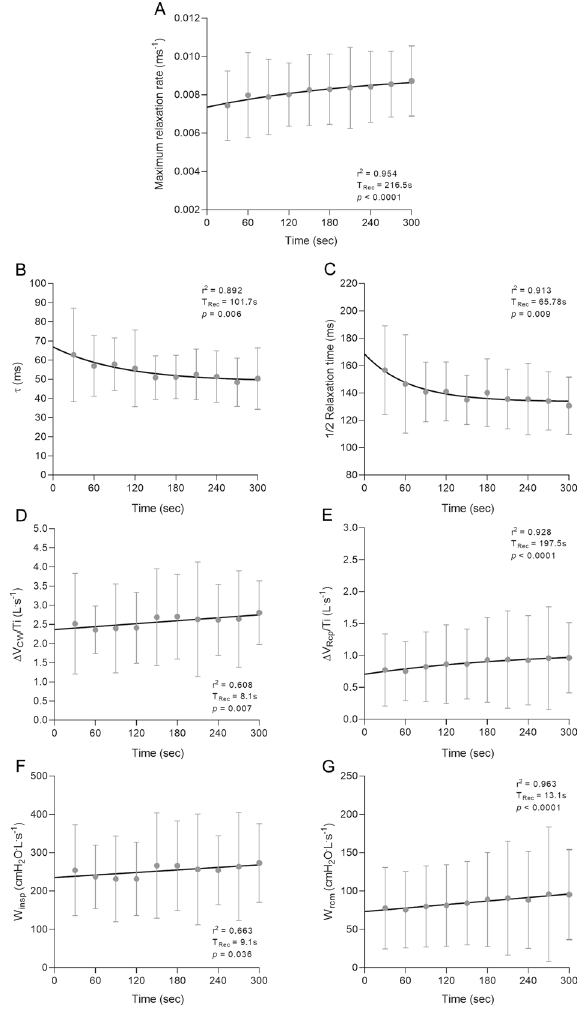
Figure 6. Time course of the recovery pattern of maximum relaxation rate (panel A ), time constant of the relaxation curve (τ—panel B ), half-time of relaxation curve (½RT—panel C ), mechanical power of global inspiratory ( Ẇ insp —panel D ) and inspiratory ribcage muscles ( Ẇ rcm —panel E ), and shortening velocity indexes of global inspiratory (ΔV CW /Ti—panel F ) and inspiratory ribcage muscles (ΔV RCp /Ti—panel G ). Each point represents mean ± SD data obtained from SNIP maneuvers performed during recovery in all 26 subjects. Lines represent regression curves that fitted maximum values in a least-square sense. sec: